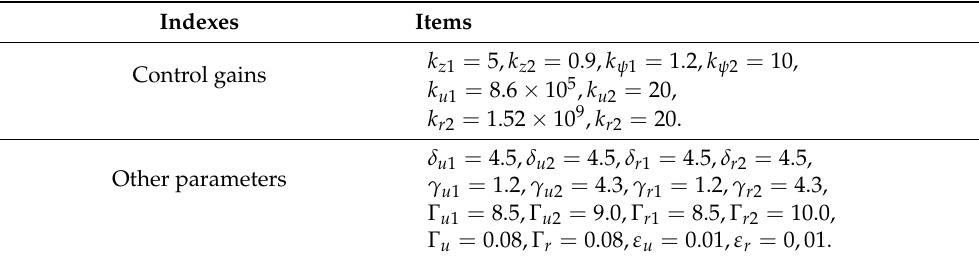
Table 1. Controller parameters for the